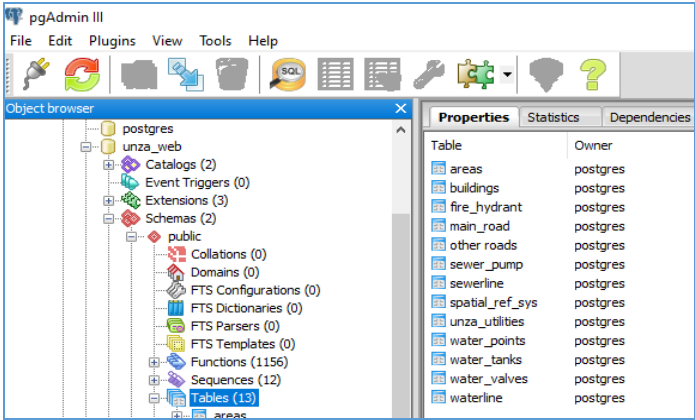
Fig. 11. Screenshot of the PostgreSQL with the UNZA existing infrastructure